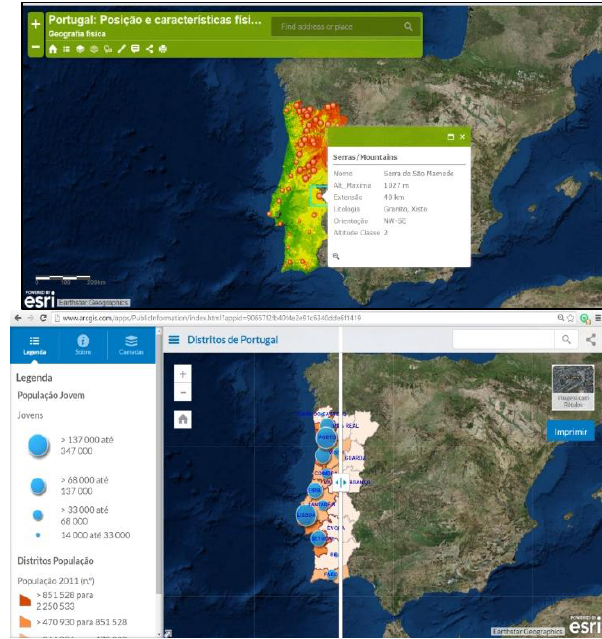
Figure 3 . Webmap layout used by fifth grade (top) and sixth grade students (bottom).